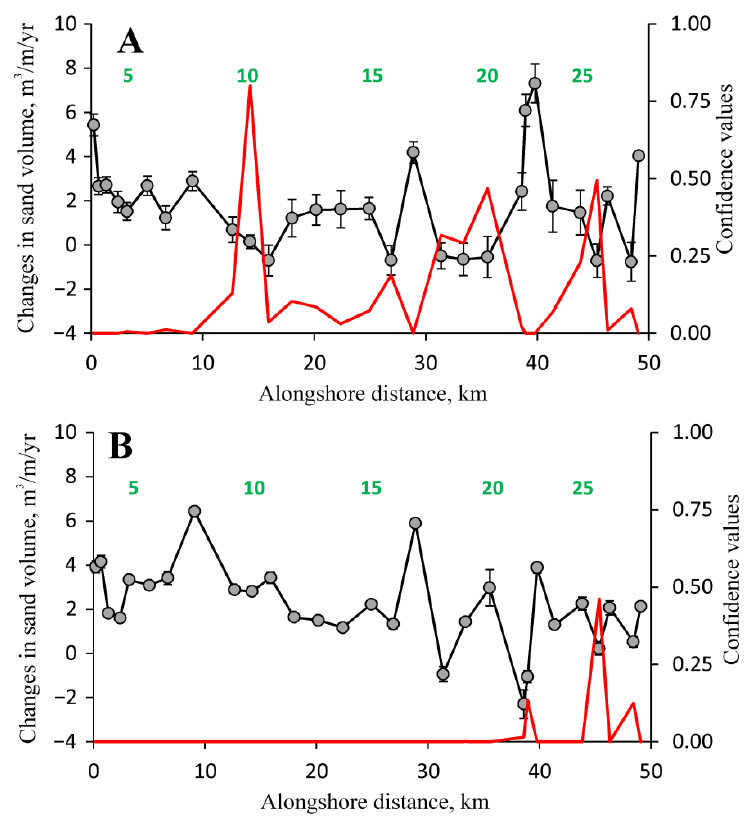
Figure 5. Linear trends (m 3 / m per year) in the ( A ) beach and ( B ) foredune volume alongshore. Distance from Klaipėda port jetties. Red line—significance level ( p -value). Green labels indicate cross-shore profile numbers.